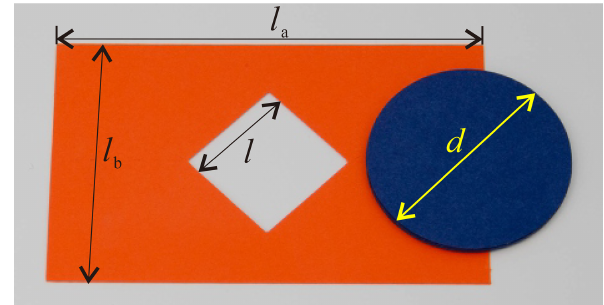
Figure 1. A paper folding toy: how to get a round disc through a smaller square hole in a piece of